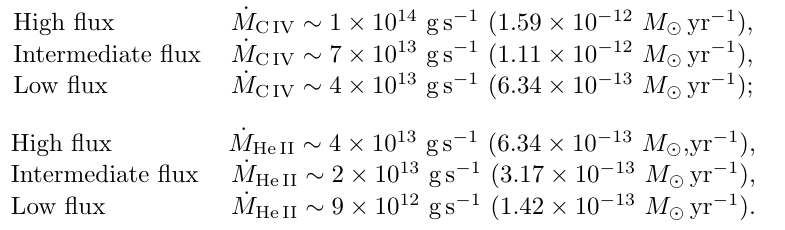
Fig. 9. Variation of the C IV line (cid:13)ux with phase for HU Aqr. The 1 (cid:27) error bars are shown on each data point. The (cid:13)ux is plotted in units of erg cm (cid:0) 2 s (cid:0) 1